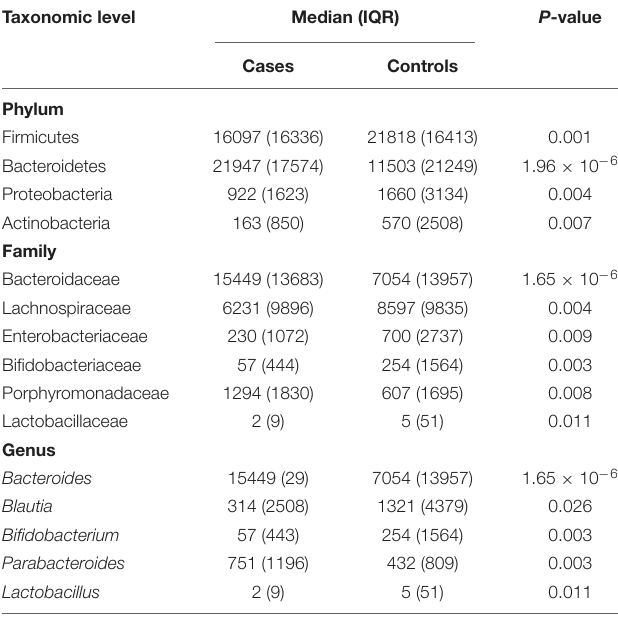
TABLE 3 | Comparisons of gut microbiota composition at several taxonomic levels between the osteoporosis patients (cases) and controls. Taxonomic